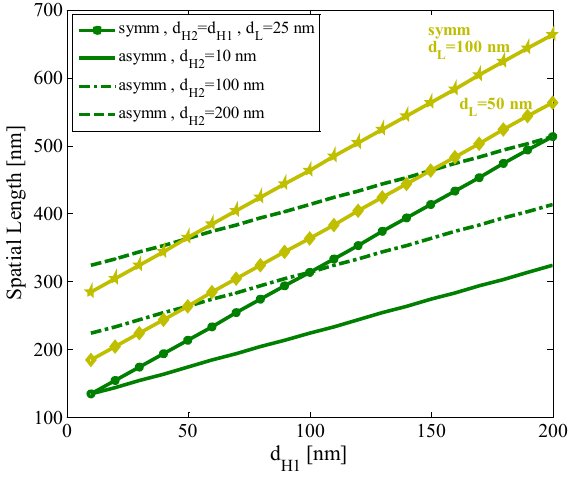
Figure 11: Spatial length of the TM 1s fundamental mode of HMIM slab waveguide for asymmetry of the H-Layer thicknesses at d L1 =d L2 = d L =25 nm (symmetrical cases of d L =25 ,50 and 100 nm are included for comparison). realization of aforementioned plasmonic slab waveguides.